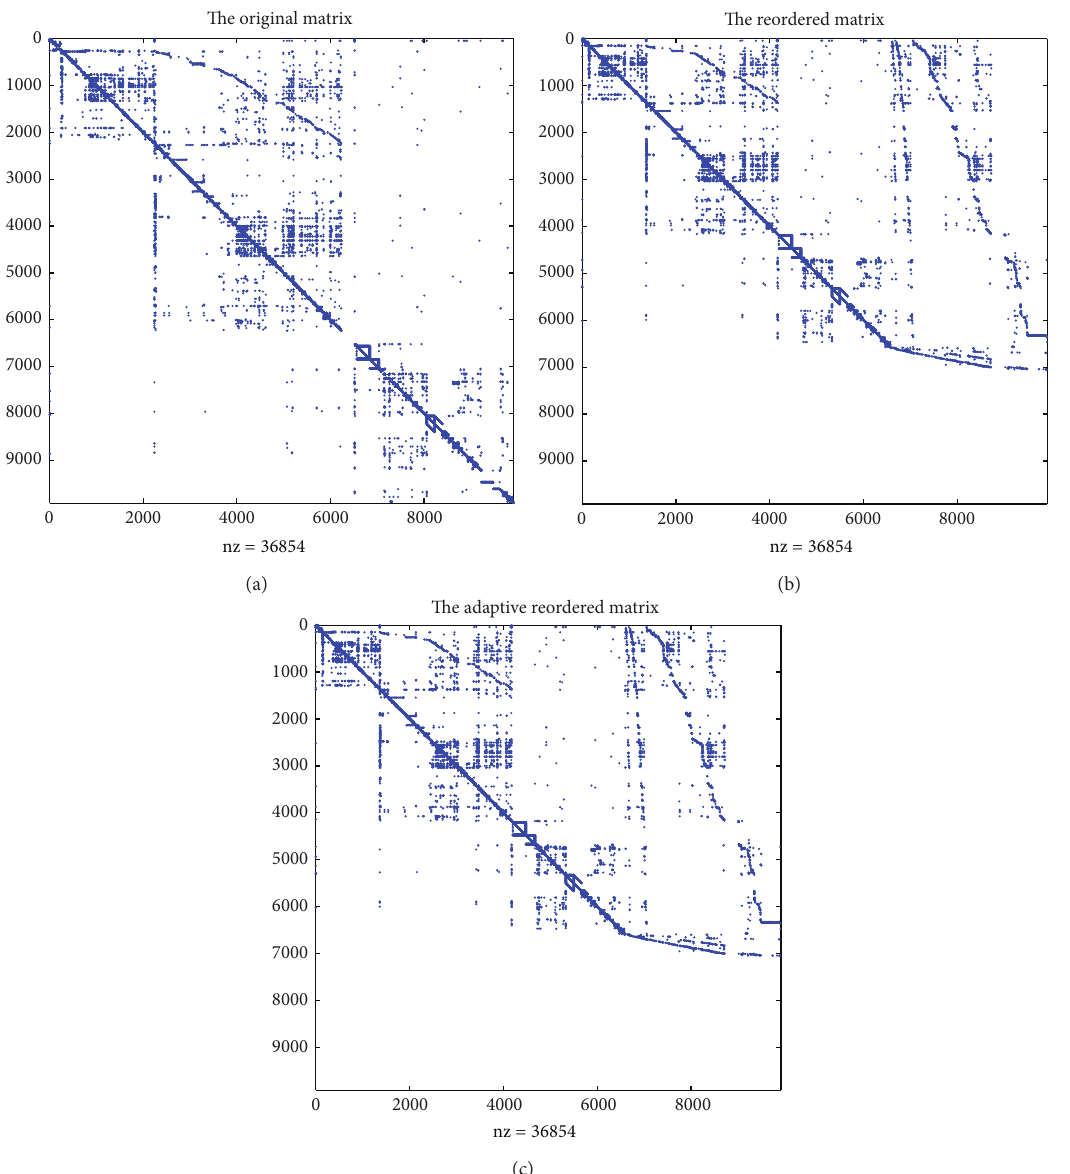
Figure 1: The resulted image of the original wb-cs-stanford.mat (a) and matrices reordered using RD and aRD ((b) and (c)).